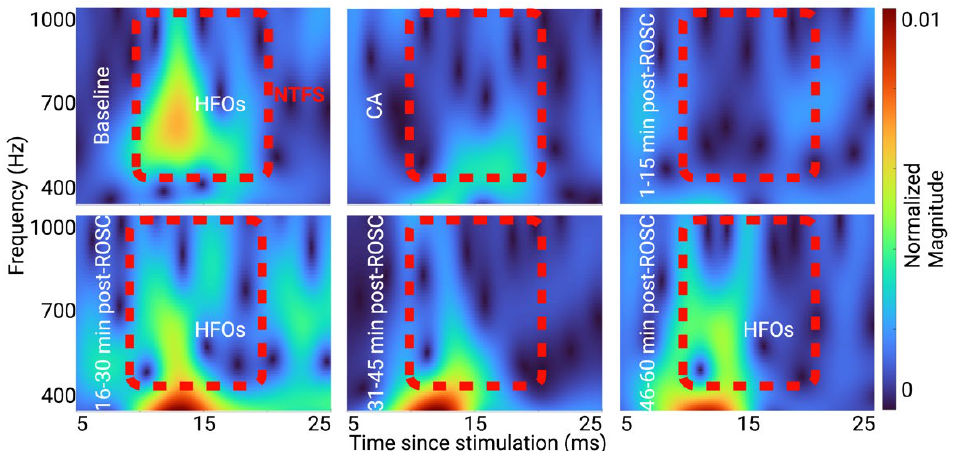
Figure 5. TF representation of grand average HFOs ( n = 11 subjects) at washout, CA, and recovery periods 1–15 min, 16–30 min, 31–45 min, 46–60 min post-ROSC. CWT was used to transform the time-domain HFOs into their TF domain representations. The scalogram for each block, or the absolute value of the CWT coefficients of HFOs, was plotted. The color scale represents the absolute value of the CWT coefficients, i.e., the power of the HFOs at a particular time and frequency. The HFOs formed a single peak around 13 ms post-stimulation and 600 Hz in the TF domain during washout. However, the TF peak dissipated after CA and gradually recovered but did not form a single peak by the end of 60 min of recovery. In addition, a sudden burst of HFOs was present during the 16–30 min block. Created with